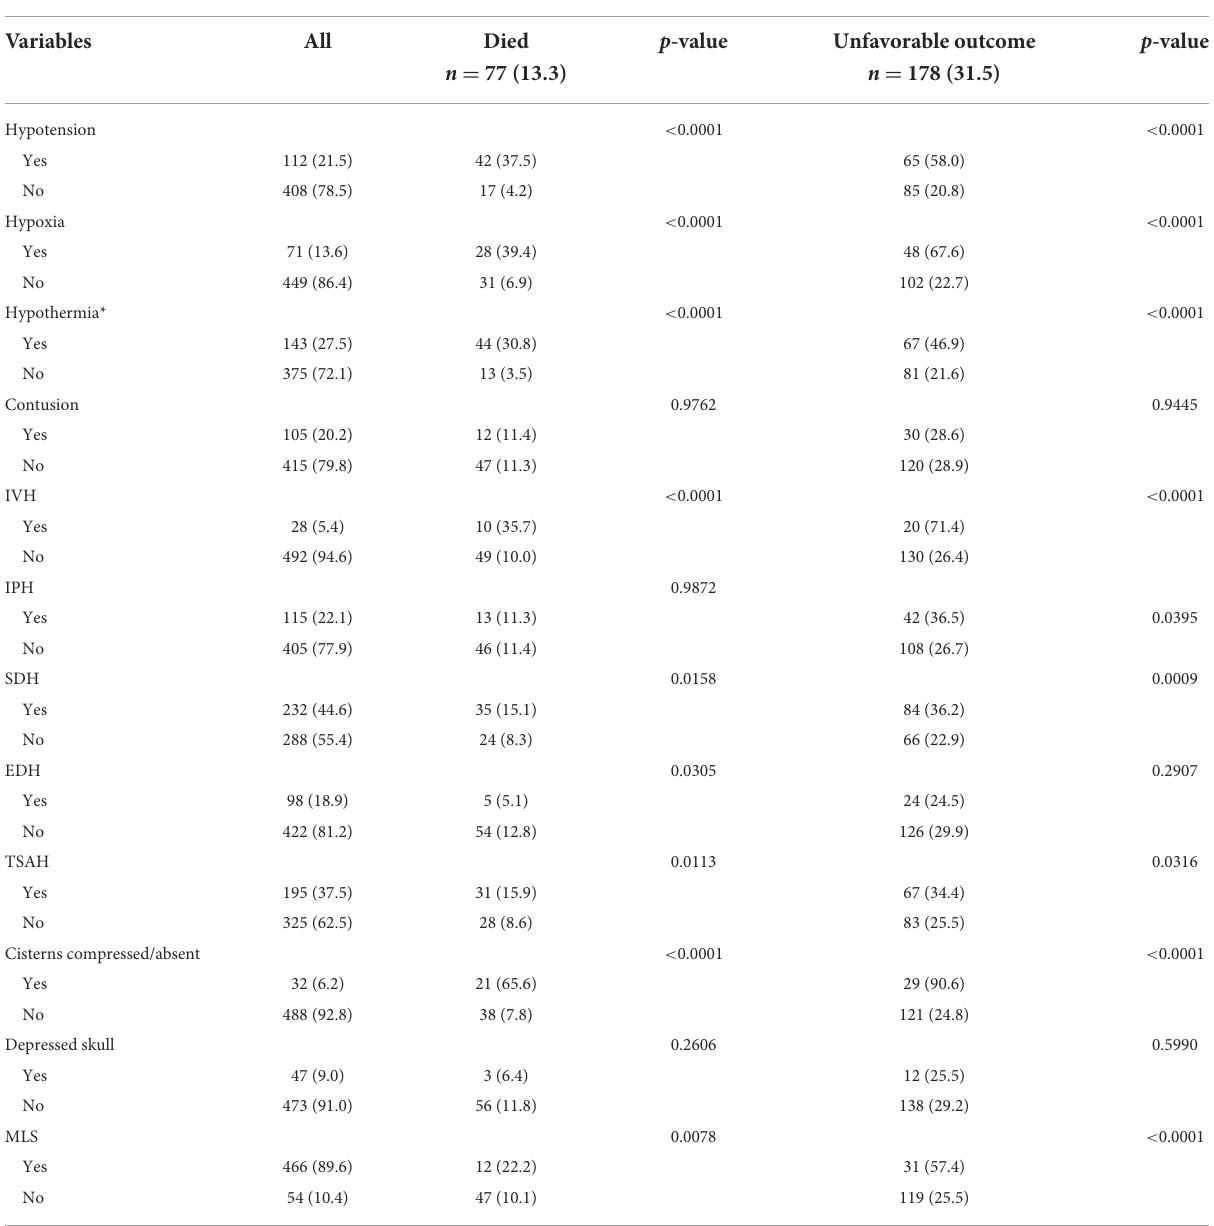
TABLE 2 Injury characteristics by outcomes at 6-month follow-up ( n = 520). Outcomes at 6 months (GOS-E)